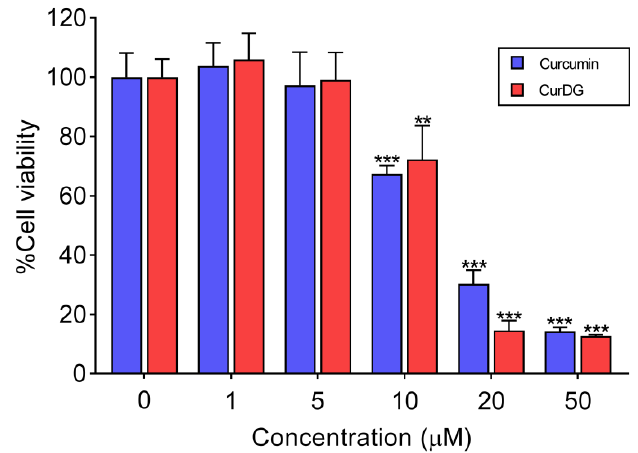
Figure 2. Effects of curcumin and CurDG on the cell viability of RAW 264.7 macrophage cells. Cells were treated with curcumin or CurDG at 1–50 μM and incubated for 24 h. Data show the mean ± SD values of three independent experiments. Note: ** p < 0.01 and *** p < 0.001 compared with the control group.